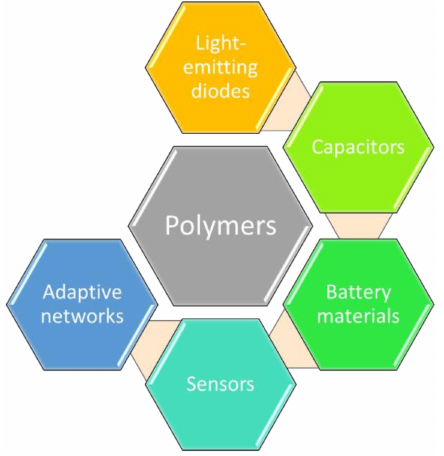
Figure 8. Application of polymers in electronic